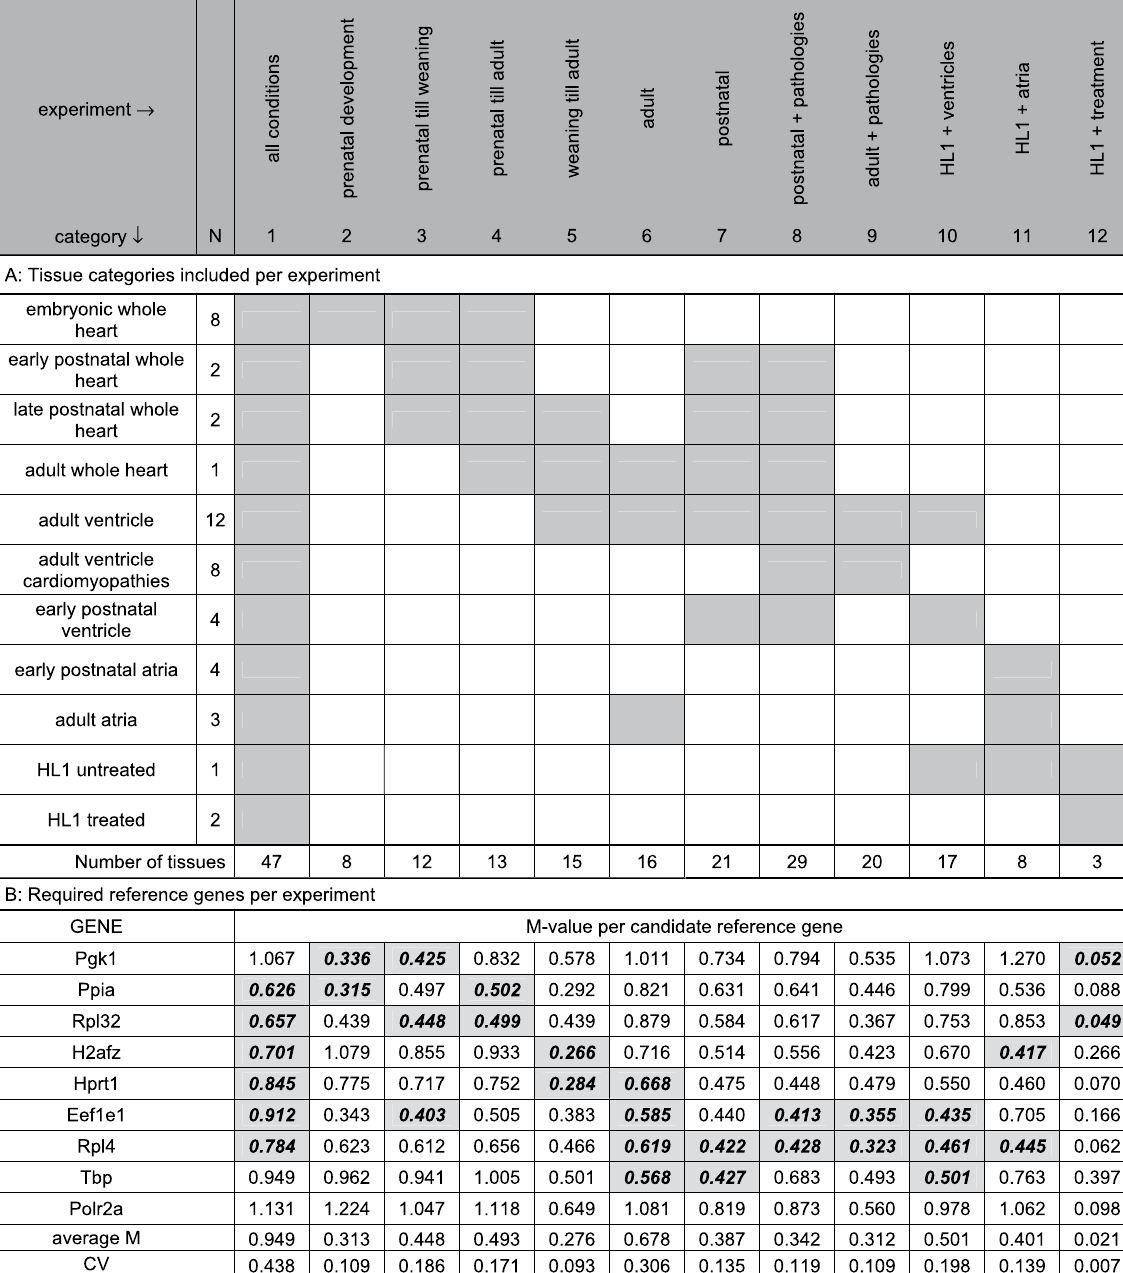
Table 1. A . Grouping of categories of tissue types (rows) into experimental conditions (columns). Per category the number of included tissue types (N) are given. B . The reference genes required for normalization per experimental condition are indicated in gray; the M-values indicate the stability of the individual candidate reference genes in the experimental conditions. The average M-value and coefficient of variation (CV) are given for the required reference genes per experiment. See Supplemental Table 1 for an overview of the tissue samples included in each category of tissue